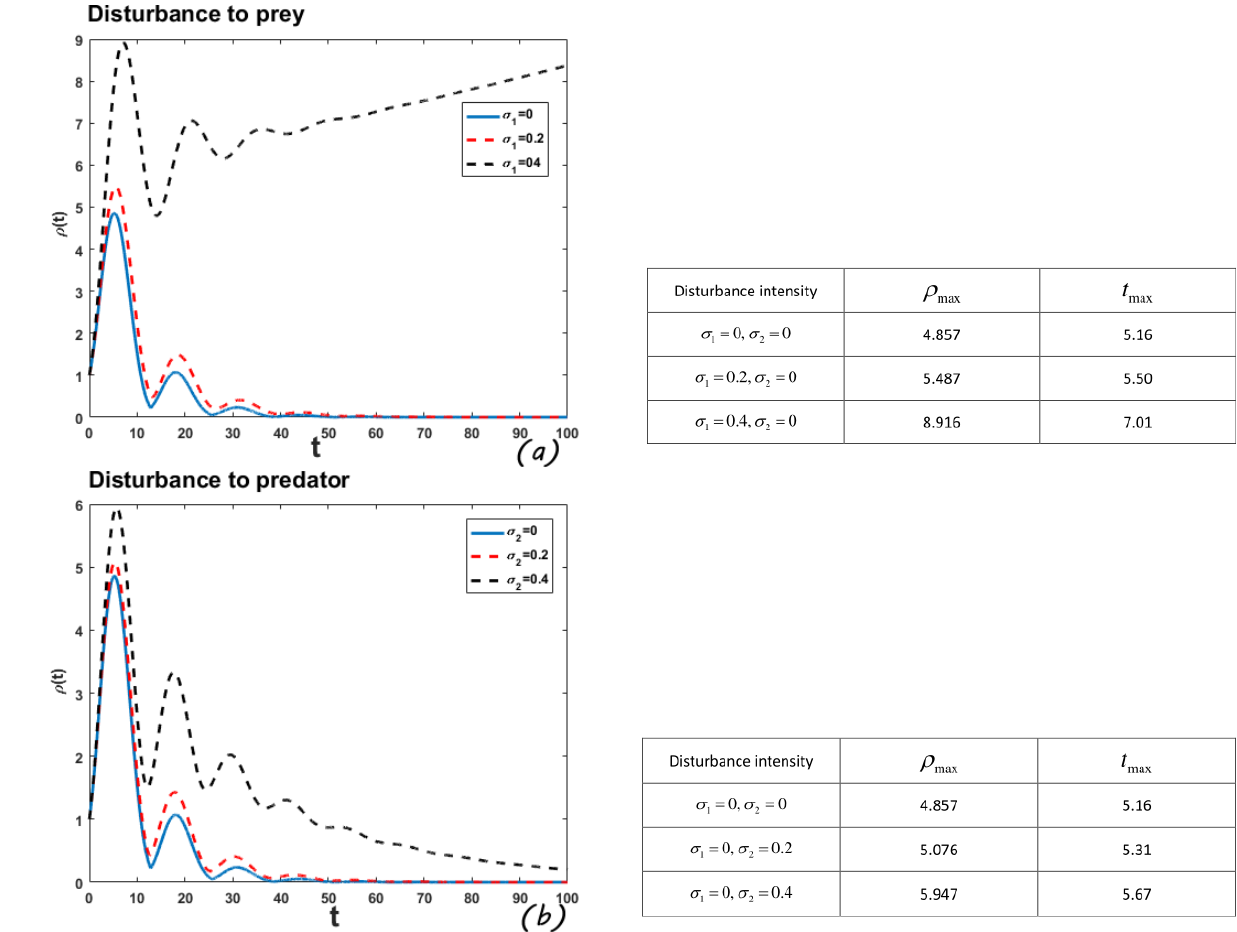
Figure 6. Amplification envelope(in the mean-square sense) of the positive equilibrium of (11). In ( a ), blue solid line: σ 1 = 0, σ 2 = 0; red dash line: σ 1 = 0.2, σ 2 = 0; black dash line: σ 1 = 0.4, σ 2 = 0. In ( b ), blue solid line: σ 1 = 0, σ 2 = 0; red dash line: σ 1 = 0, σ 2 = 0.2; black dash line: σ 1 = 0, σ 2 =